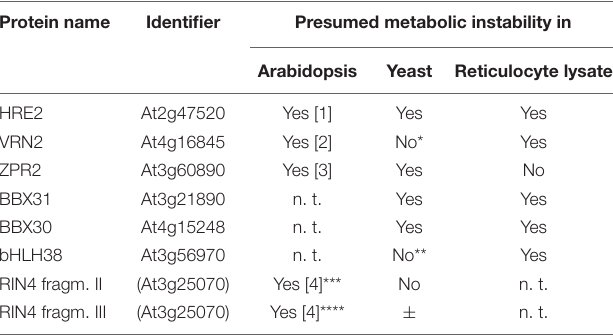
TABLE 1 | Arabidopsis proteins investigated as fusions to GFP for stability in modified yeast